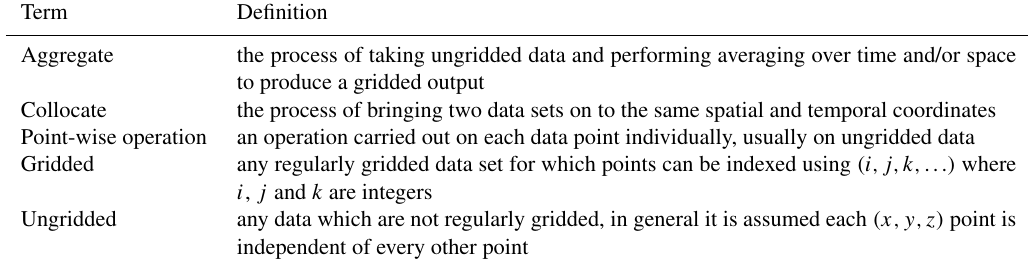
Table A1. A table of terms in this